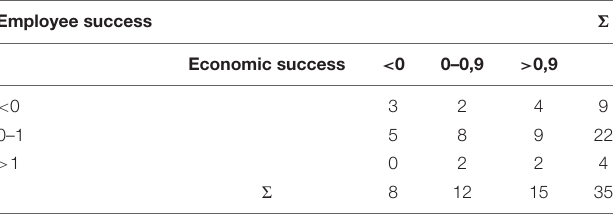
TABLE 4 | Distribution of economic success and employee-related success. Employee